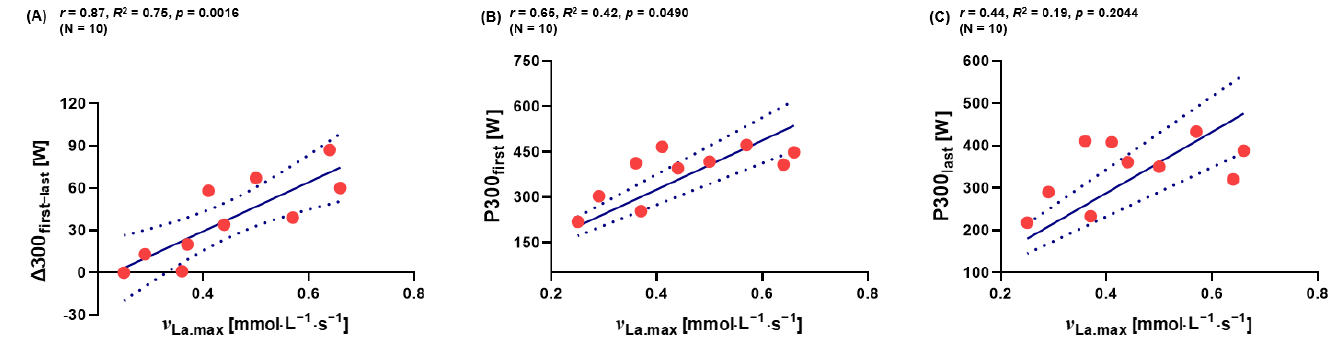
Figure 5. Correlation analyses. Relations between ( A ) the ν La.max value and ∆300 first − last during 2000 m RTT ( N = 10), between ( B ) first 300 m during 2000 m RTT and ν La.max ( N = 10), and between ( C ) last 300 m during 2000 m RTT and ν La.max ( N = 10). ∆ : Delta 300 first − last ; subtraction of P300 first and P300 last . Dotted lines: 95% confidence interval, straight line: strength of the linear relationship between two variables.